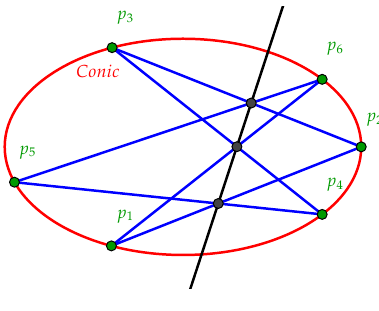
Figure 2. Pascal line of the